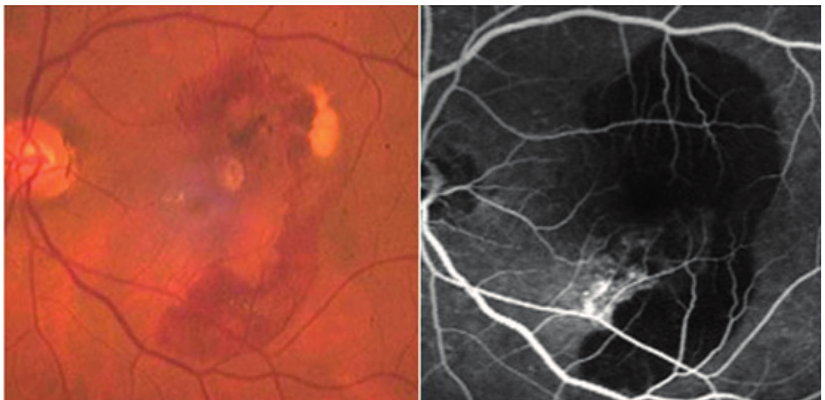
Figure 2. Age-related macular degeneration (AMD) and fluorescein angiography.